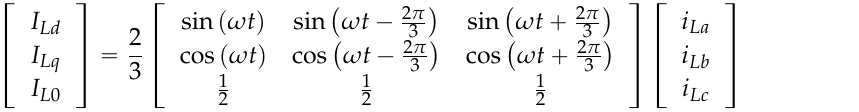
Figure 2. Harmonics extraction based on SRF algorithm.